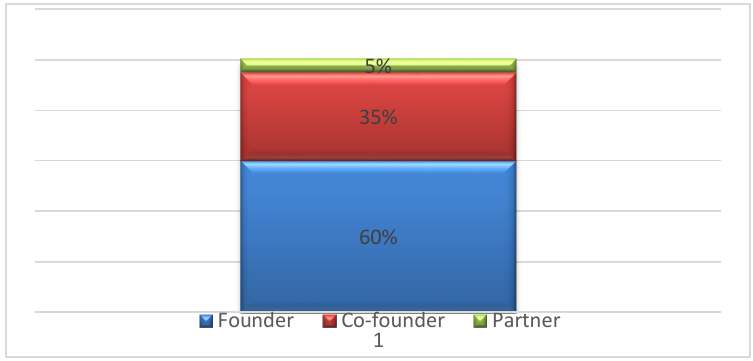
Figure 5: The Distribution of Respondent Profiles: Age Groups ; Source: Author